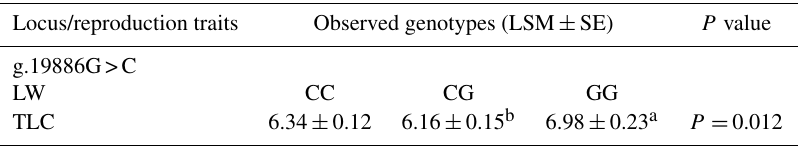
Figure 2. Linkage disequilibrium plot of the SPEF2 gene in LW and LD pigs. (a) D (cid:48) of LW, (b) r 2 of LW, (c) D (cid:48) of LD, and (d) r 2 of LD. Table 5. Relationship between the g.19886G>C locus of the pig SPEF2 gene and reproduction